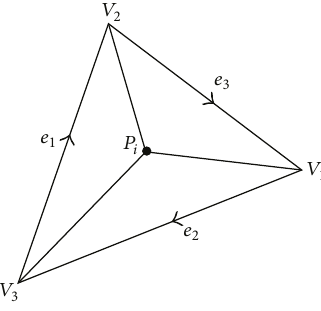
Figure 1: Splitting 𝐾 into three subregions by 𝑃 𝑖 (figure reproduced from [15] [under the Creative Commons Attribution License/public